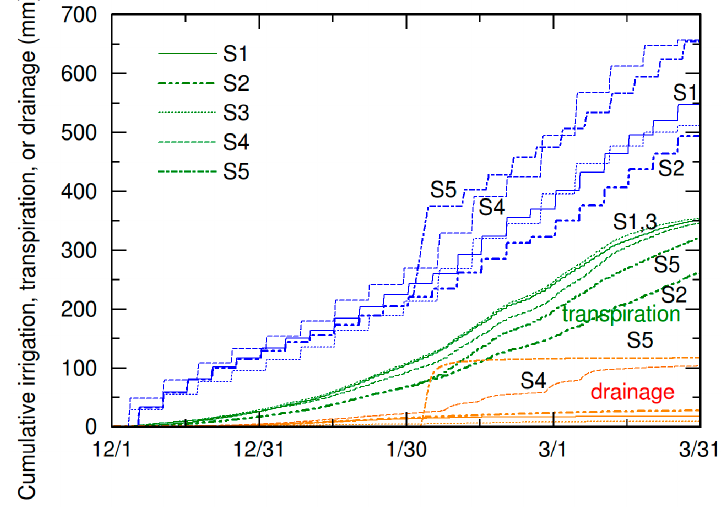
Figure 4. Time evolution of cumulative irrigation, transpiration and drainage for each scenario. Blue, green, and orange lines represent irrigation, transpiration, and drainage, respectively. Water 2020 , 12 , x FOR PEER REVIEW